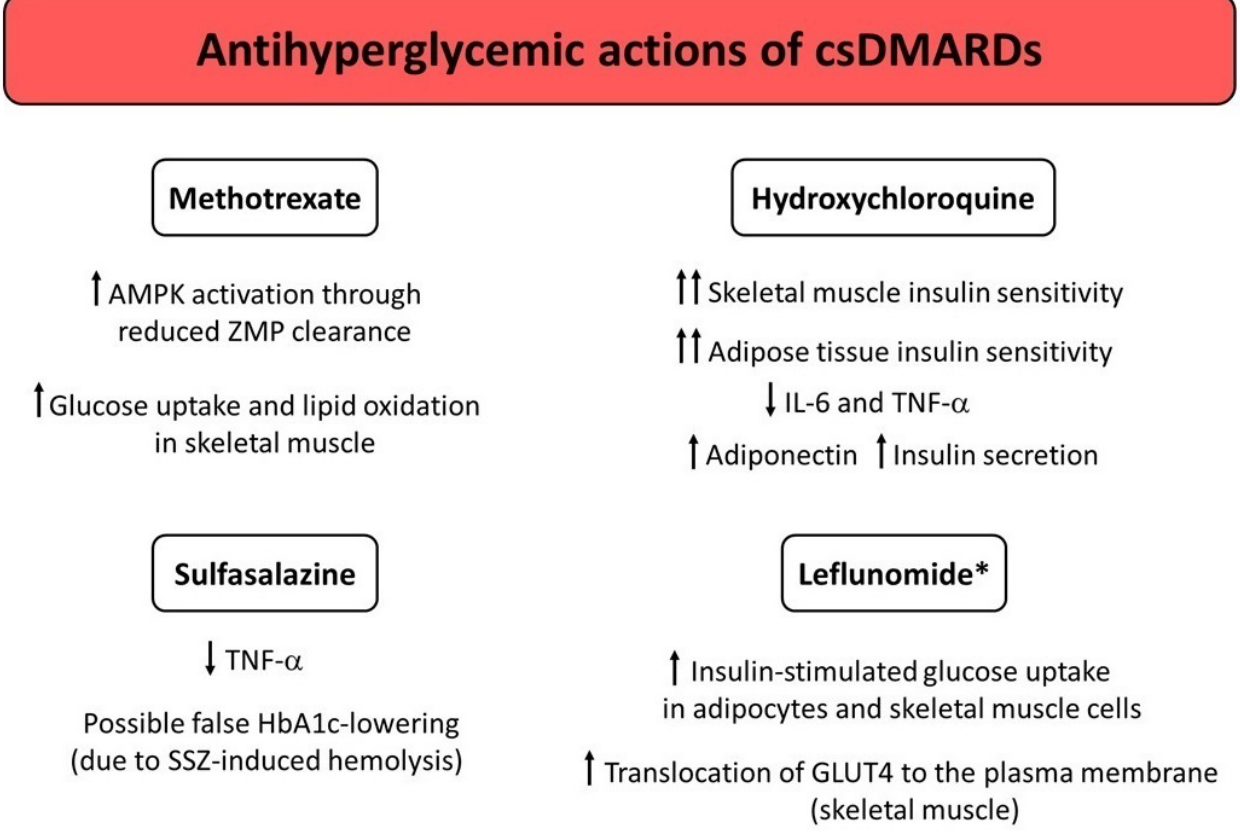
Figure 1. Potential mechanisms underlying the antihyperglycemic actions exerted by conventional synthetic DMARDs (csDMARDs). * Studies conducted in mice only. Abbreviations: AMPK, adenosine monophosphate-activated protein kinase; DMARDs, disease-modifying antirheumatic drugs; GLUT4, glucose transporter type 4; HbA1c, glycated hemoglobin; IL, interleukin; SSZ, sulfasalazine; TNF- α, tumor necrosis factor α; ZMP, aminoimidazole carboxamide ribonucleotide (AICAR) monophosphate.